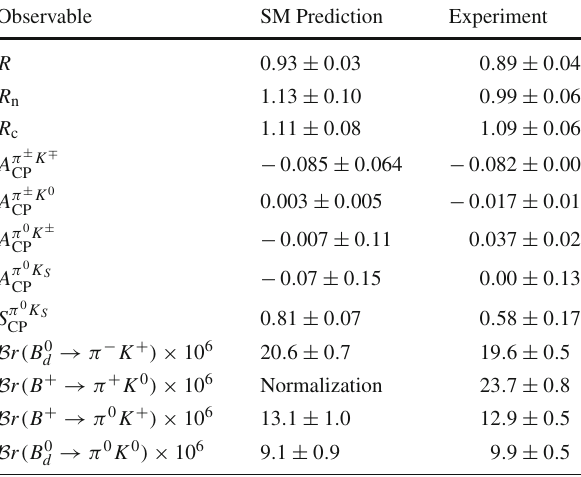
Table 4 SM predictions of the B → π K observables and comparison with the current experimental data Observable SM